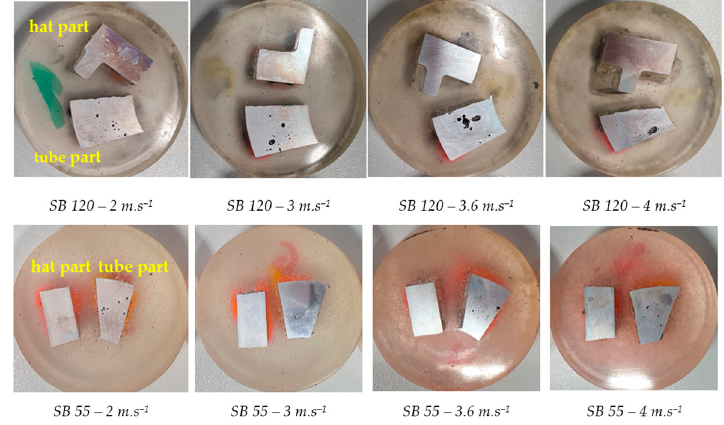
Figure 8. Visual examination of the specimens.